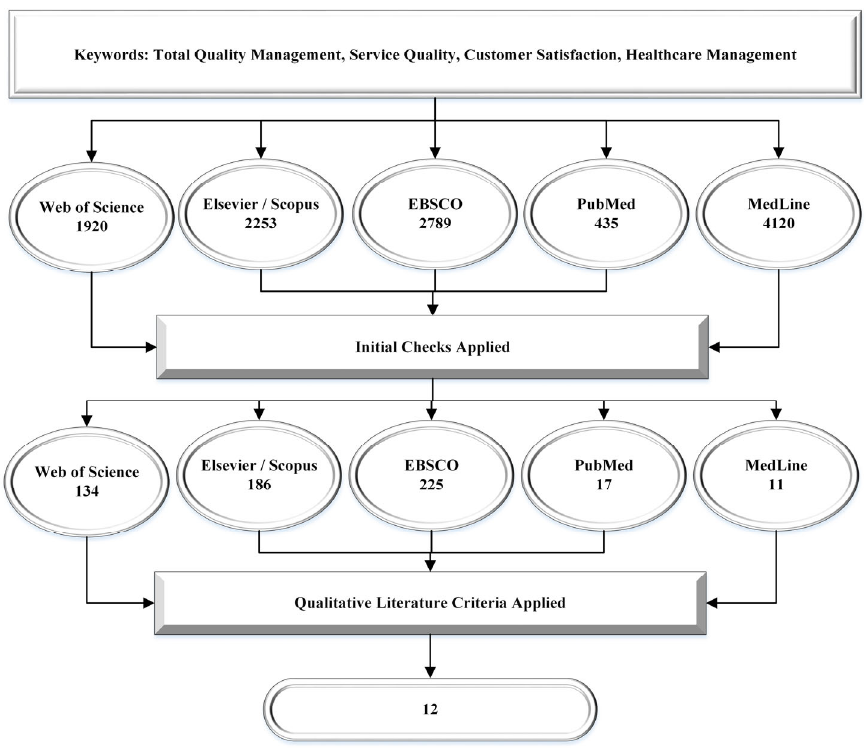
Fig. 1. Qualitative Systematic